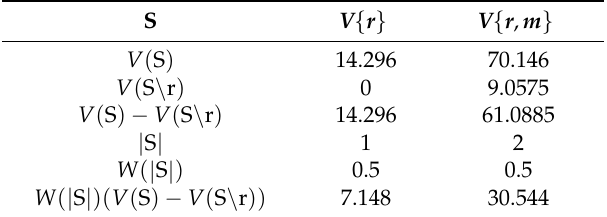
Table 4. Income distribution for resource developers under a cooperative centralized decision.